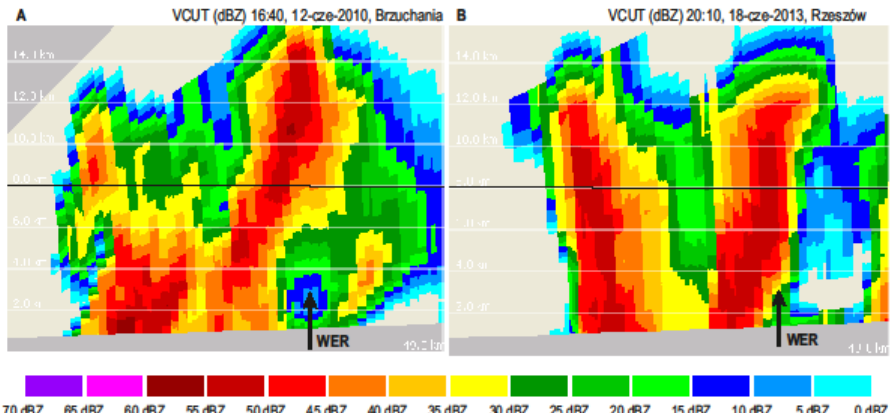
Fig. 7. Vertical cross-sections of the supercell storms. A – RM supercell storm near Sandomierz with hail up to 6,5 cm in diameter. Radar Brzuchania, June 12, 2010 and B - Vertical cross-section through the supercell storms during the splitting process. June 18, 2013 south-eastern Poland. Two storms met Lemon criterion. Slight WER was also visible. Black line denotes the height of 8